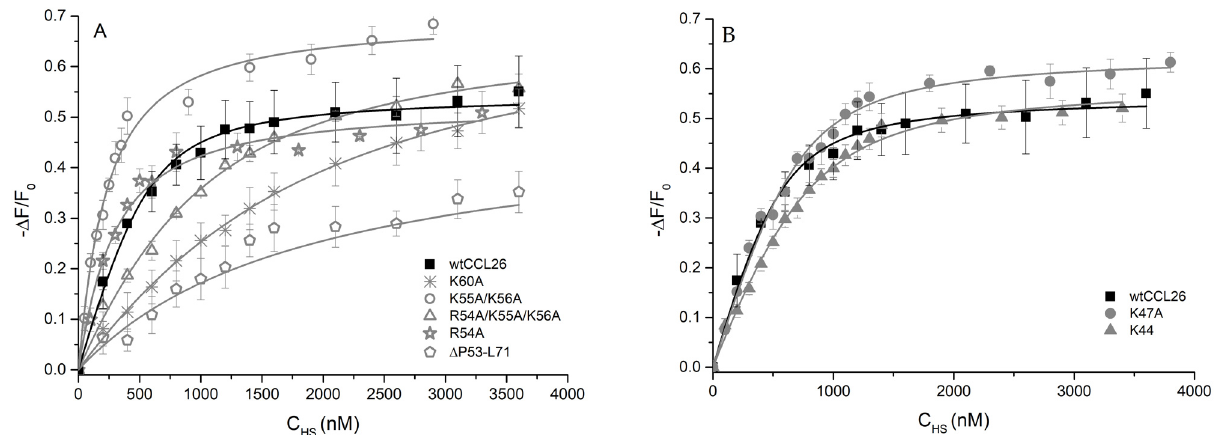
Figure 5. Heparan sulfate-binding isotherms of CCL26 mutants in α -helix ( A ) and β -sheet ( B ). Wildtype isotherms are shown in black. On the y-axis, the relative change in fluorescence intensity following ligand addition is displayed: Δ F = F (fluorescence emission at a certain ligand concentration)—F0 (fluorescence emission in the absence of ligand).